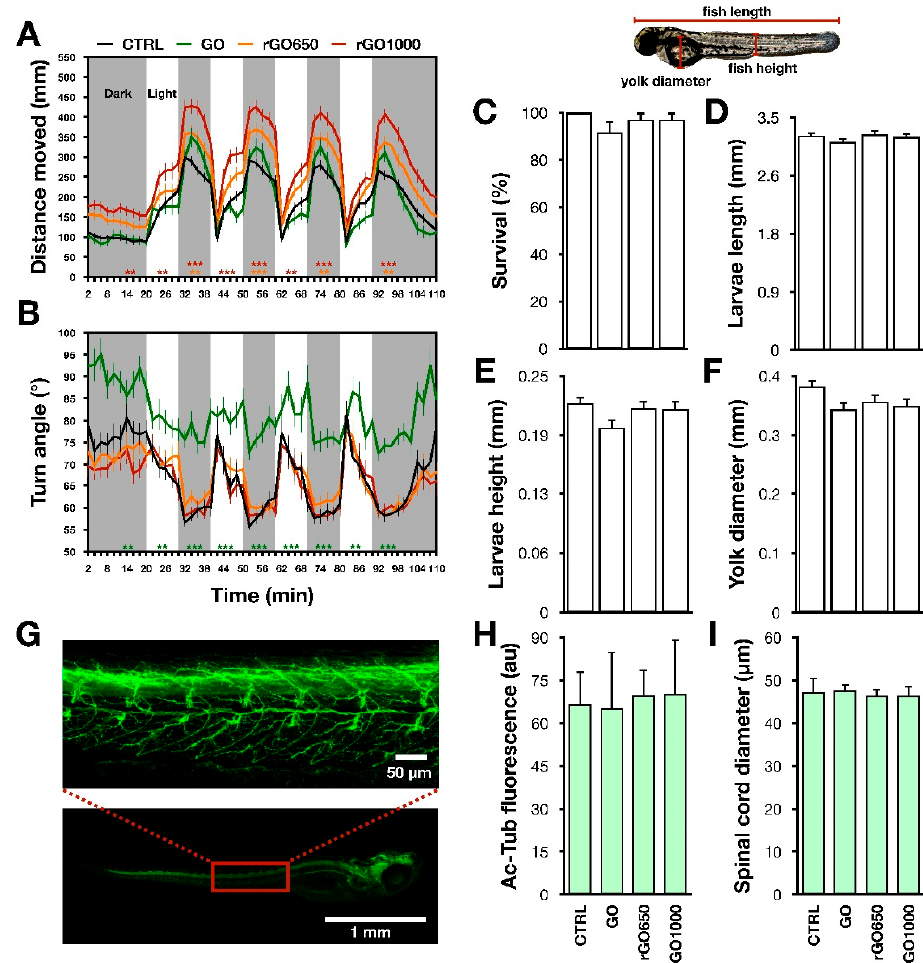
Figure 3. Representations of 24-h-long chronic exposure of zebrafish larvae to GRMs. Locomotor activity of larvae subjected to light and dark alternating 10 min periods was analyzed for the distance moved ( A ) and turn angle ( B ). Bar plots reported the anatomical analysis of larvae (in the inset on the top, the measured parameters), respectively the survival ( C ), larvae length ( D ), height ( E ) and yolk diameter ( F ). On the bottom, a representative image of a whole mounted larvae labelled with the neuronal marker acetylated-tubulin (Ac-Tub), while on the top the spinal cord region in the red square is magnified ( G ). Bar plots of the Ac-tub fluorescence intensity ( H ) and spinal cord diameter ( I ). Statistical significance reported to the CTRL and expressed as ** p < 0.002, *** p < 0.001.